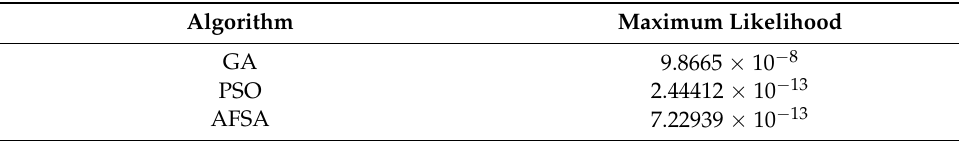
Table 5. The maximum likelihood of each algorithm.